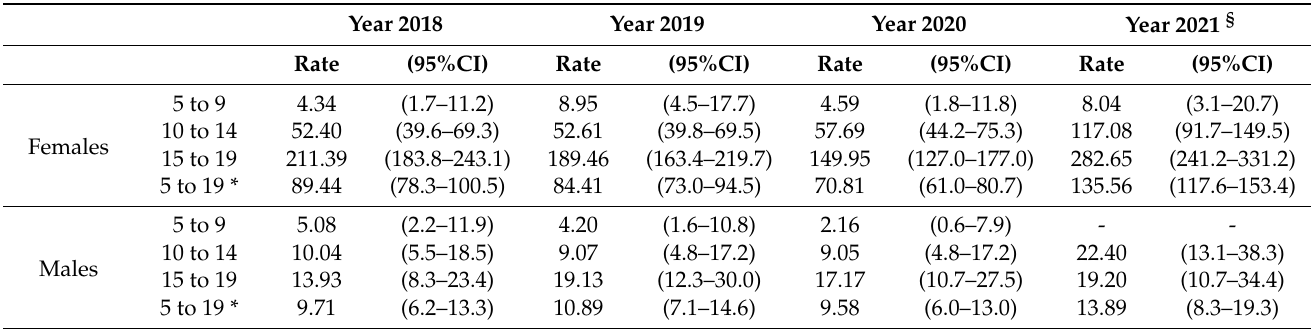
Table 2. Gender age-specific and age-adjusted (with 95% CIs) EDs hospital admissions rate per